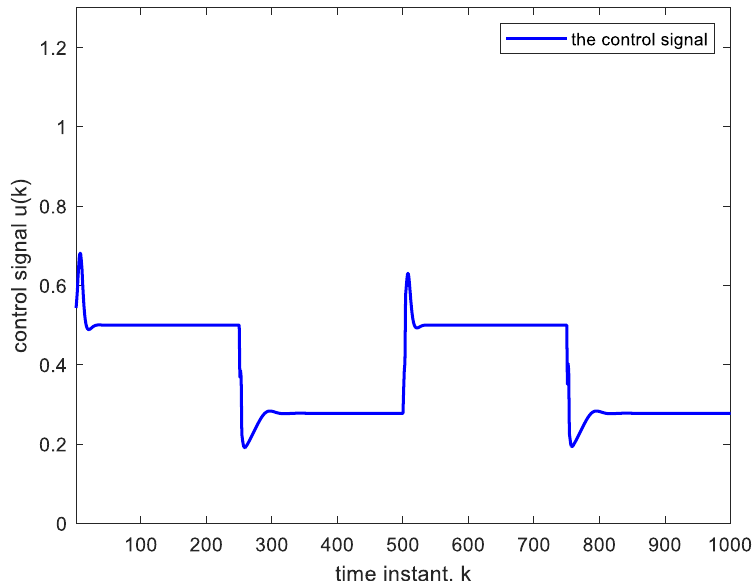
Figure 5. Control signal corresponding to Figure 4.